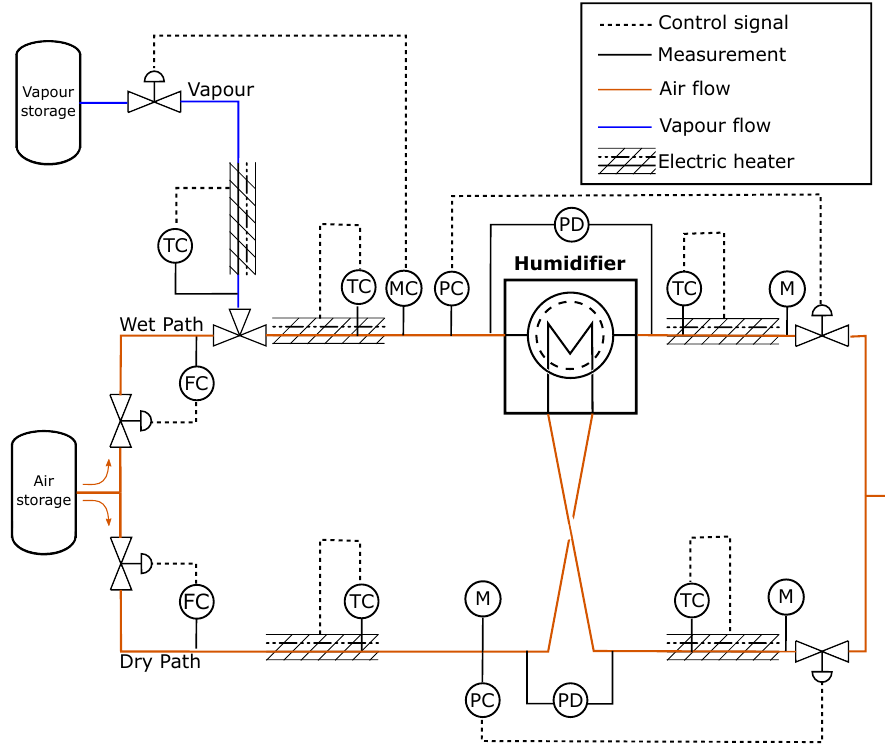
Figure 2. Piping and instrumentation diagram of the test stand used to investigate the water transport in the hollow fibre membrane humidifier at various inlet conditions. Flow (F), temperature (T), moisture (M) and pressure (P) sensors are installed. Control variables are marked by a ‘C’. Pressure difference measurements are marked with a